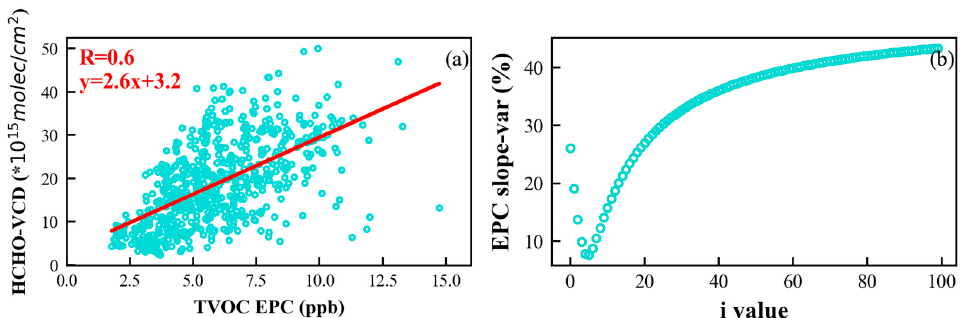
Figure 3. ( a ) Correlation analysis between HCHO VCD and TVOC reactivity; ( b ) slope-variability with different i values .